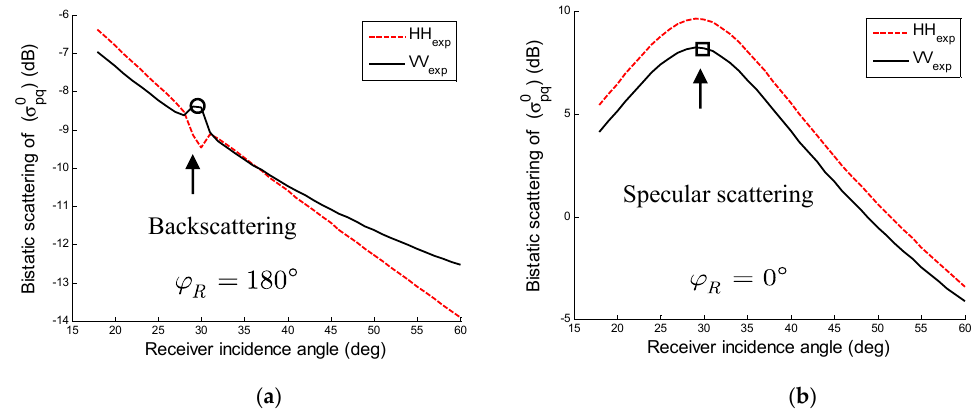
Figure 13. Bistatic scattering coefficients and when with exponential ACF.